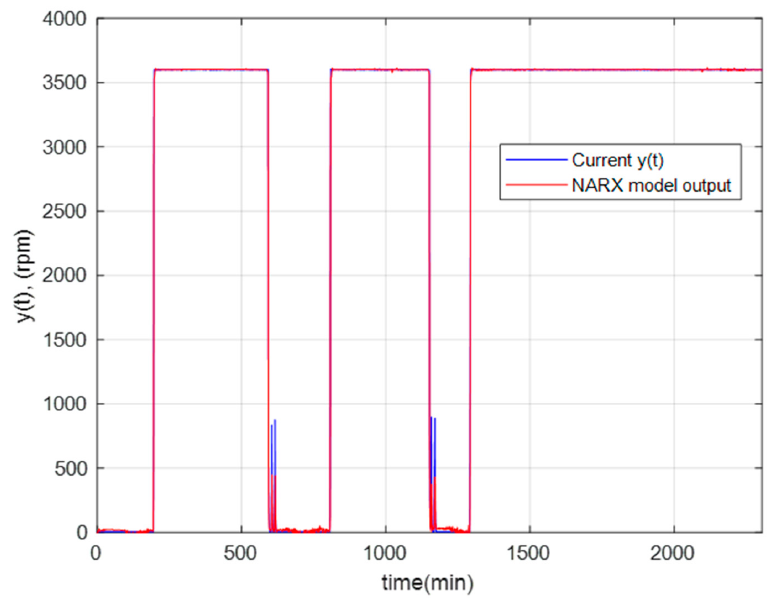
Figure 12. Behavior of the real angular velocity and the optimal NARX model for the GTL.